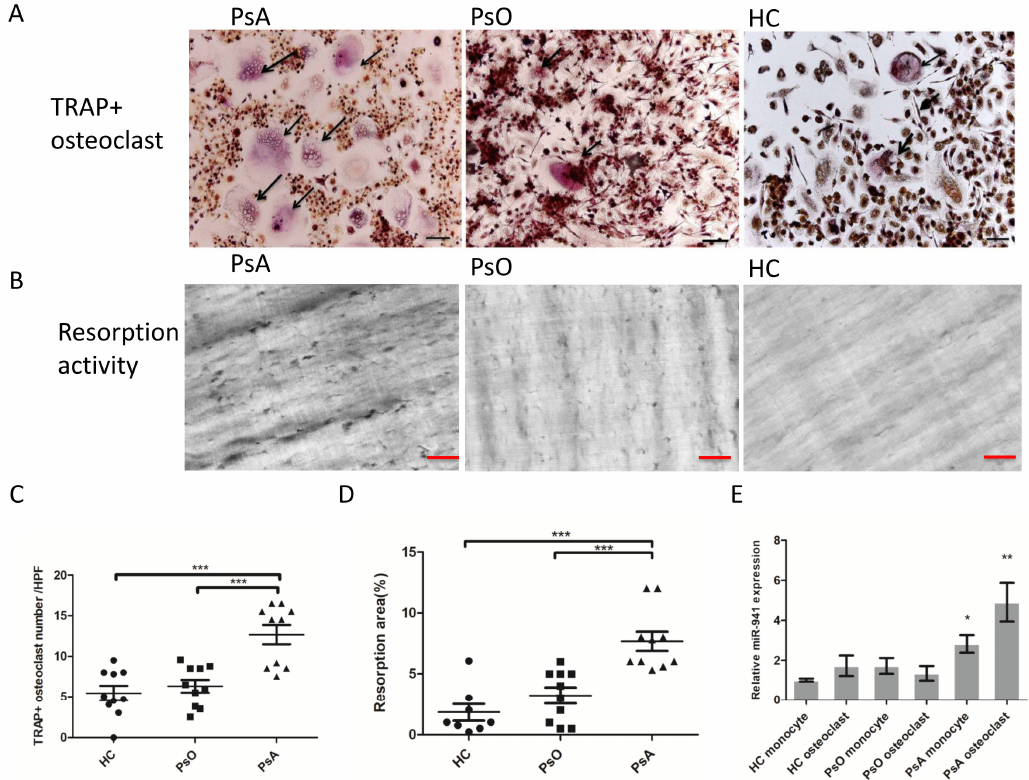
Figure 2. PsA patients with higher miR-941 expression demonstrated increased osteoclast differentiation potential and resorption activity derived from CD14+ monocytes. CD14+ monocytes from PsA patients, PsO patients, and HCs were cultured with macrophage colony-stimulating factor (M-CSF) 20 ng/mL for three days, followed by nine days in 100 ng/mL receptor activator of nuclear factor- κ B ligand (RANKL) and 100 ng/mL tumor necrosis factor- α (TNF- α ) for osteoclast differentiation. For evaluation of resorption activity, the osteoclasts were cultured on dentine slices. ( A ) At day 13, cells were stained with tartrate-resistant acid phosphatase (TRAP) to calculate the number of CD14+ monocyte-derived osteoclasts from PsA patients and NCs. Scale bar: 50 μ m. ( B ) At day 13, resorption pits made by osteoclasts from psoriatic patients and NCs were recorded under a bright field microscope. Scale bar: 50 μ m. ( C ) Osteoclast formation from CD14+ monocytes was compared between 10 HCs, 10 PsO patients, and 10 PsA patients. The number of osteoclasts was quantified among the three groups. ( D ) The eroded surface area on the dentine slices from PsA patients ( n = 10), PsO patients ( n = 10), and HCs ( n = 10) were quantified using ImageJ and expressed as % of total dentine slice area. ( E ) The expression of miR-941 in monocytes and osteoclasts from PsA patients are higher than that from HCs and PsO patients using qRT-PCR. ** p < 0.01 and *** p < 0.001.